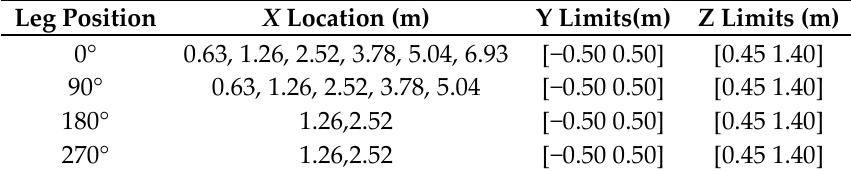
Figure 1. Wind-tunnel set up of the Monash cycling mannequin and probe measurement system in the wake. Table 1. Measurement details of the two dynamic pressure probes in the wake of the Monash cycling